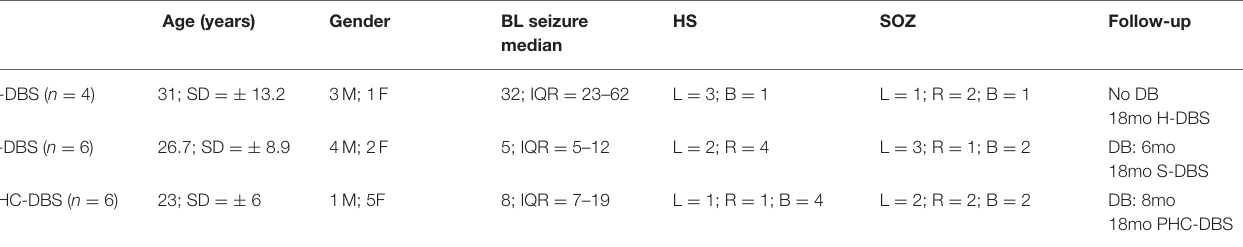
TABLE 1 | Demography of cases of temporal lobe epilepsy and hippocampus sclerosis treated with deep brain stimulation (DBS) in the hippocampus (H), Subiculum (s), and para-hippocampal cortex